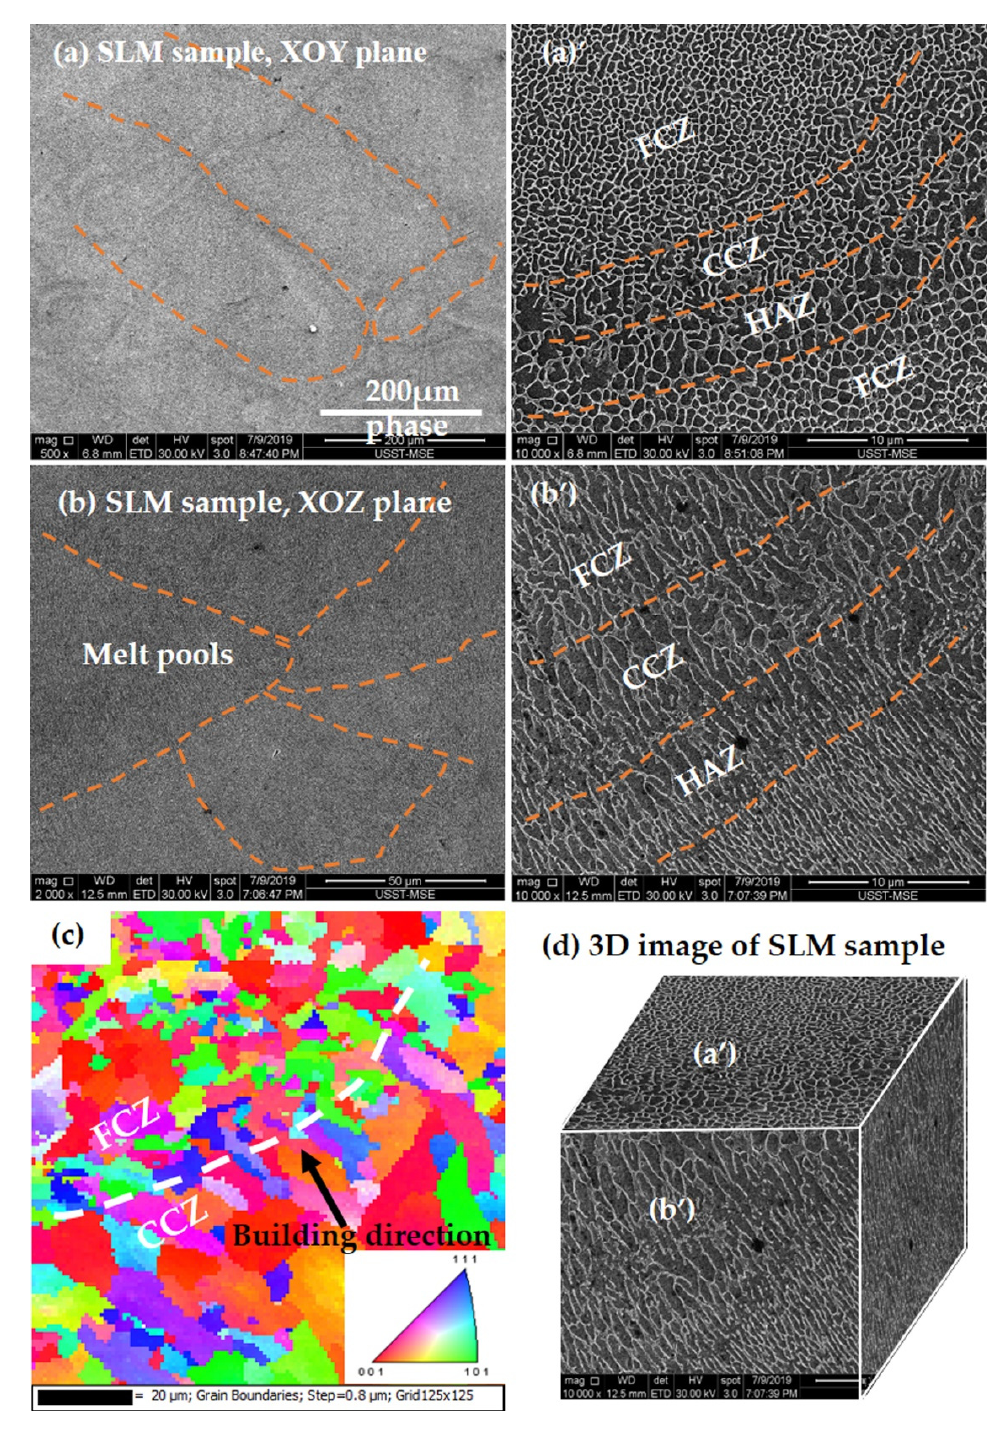
Figure 8. SEM microstructures of SLM Al-10Si-0.5Mg alloy: ( a , a’ ) along the transverse direction (XOY) where ( a’ ) is the enlarged view of selected area in ( a ); ( b , b’ ) along longitudinal direction (XOZ) where ( b’ ) is the enlarged view of selected area in ( b ); ( c ) EBSD grain structure along longitudinal direction; ( d ) 3D microstructure constructed with 10,000 × SEM images.